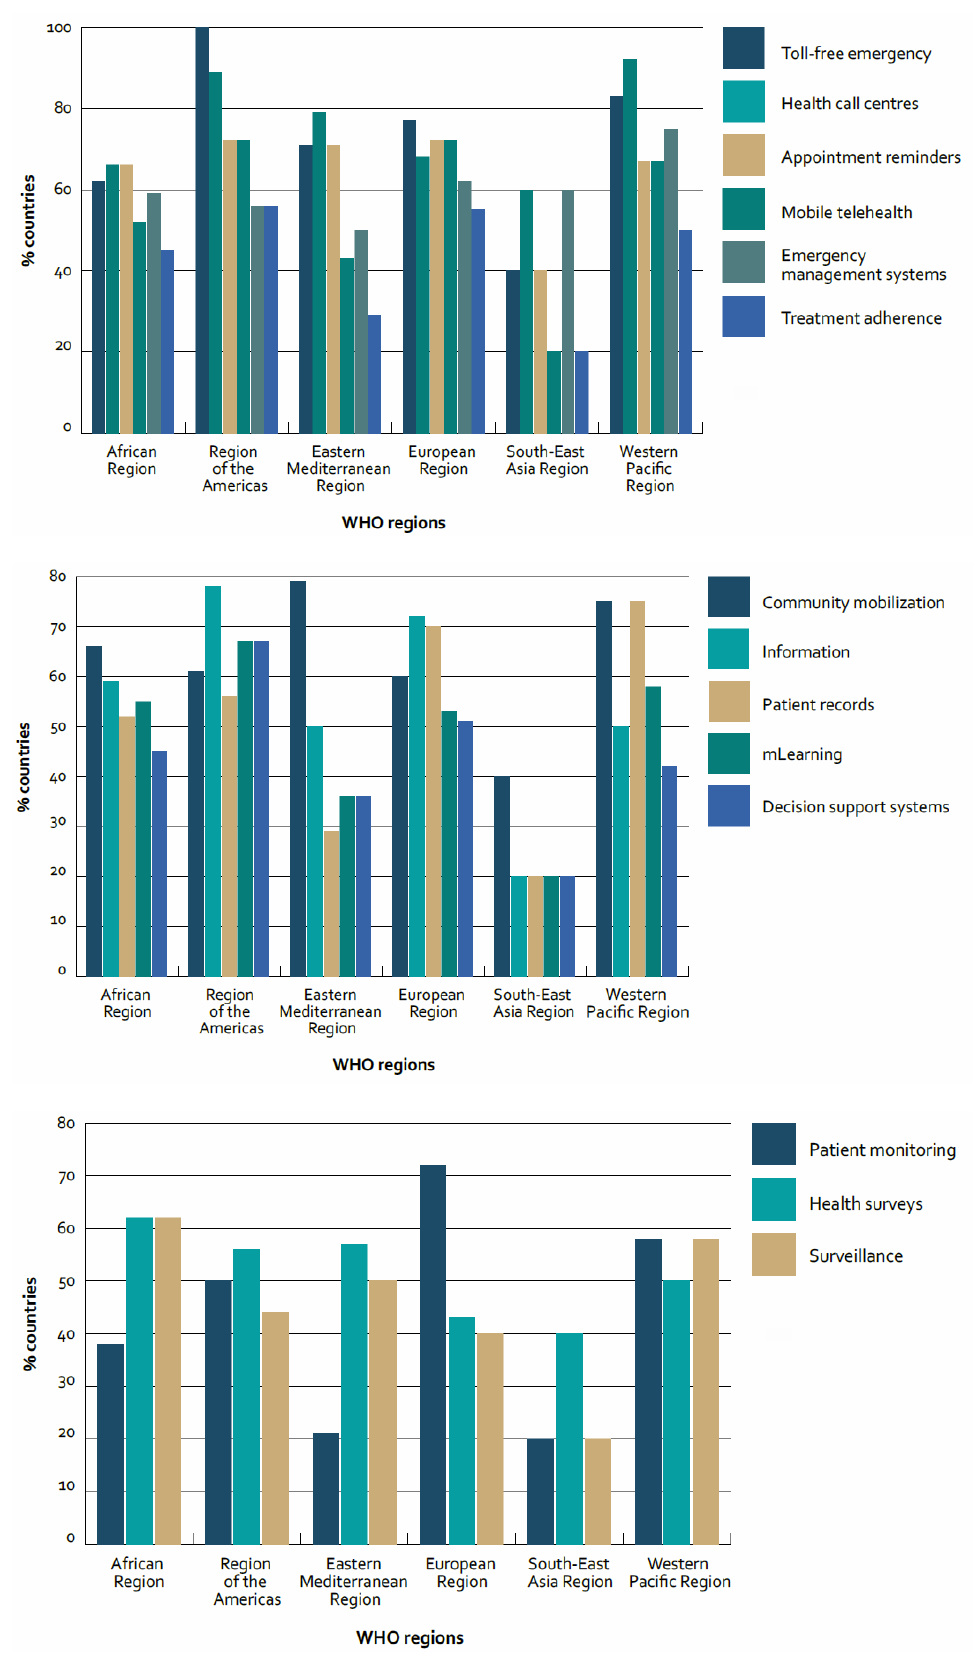
Figure 1. Percentage of countries reporting mHealth programmes for accessing/providing health services by WHO region